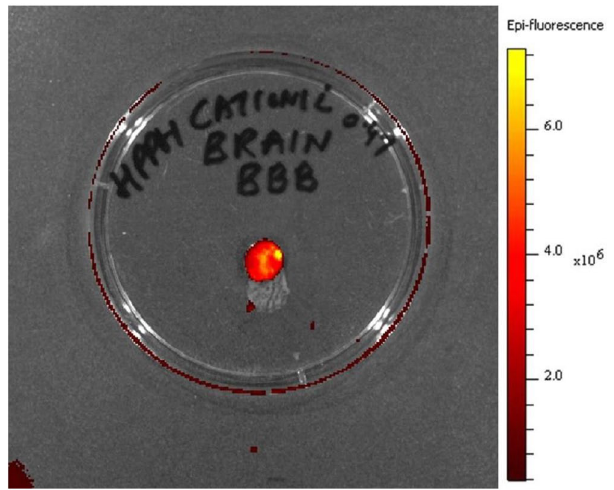
Figure 7. HPPH in cationic PAA-NMe 3+ NPs (dose: 0.47 μmol/kg was intravenously injected in a normal BALB/c mouse. At 24 h post-injection, the brain of the mouse was removed, placed in a petri dish and imaged by IVIS Spectrum [Ex (HPPH): 675 nm, and Em: 720 nm], indicating that HPPH in nano-formulation crosses the intact blood brain barrier